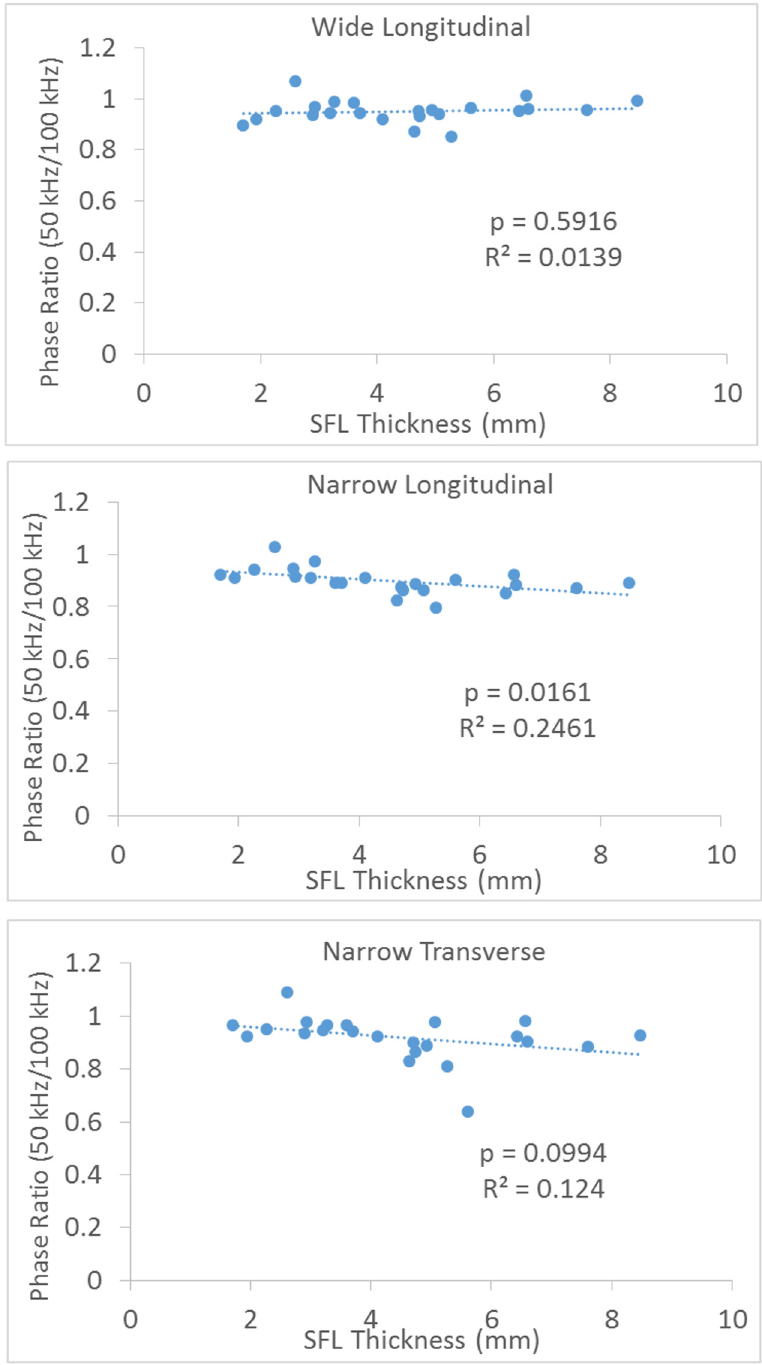
Fig 8. Correlation of 50 kHz/100 kHz phase ratio with SFL